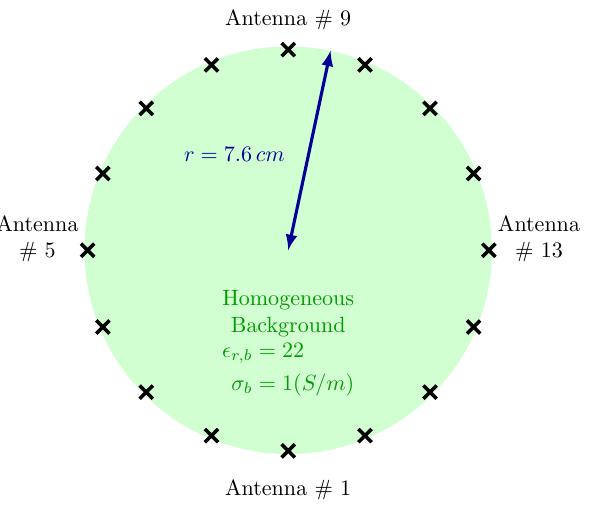
Figure 5. Schematic representation of imaging domain together with the antenna array.